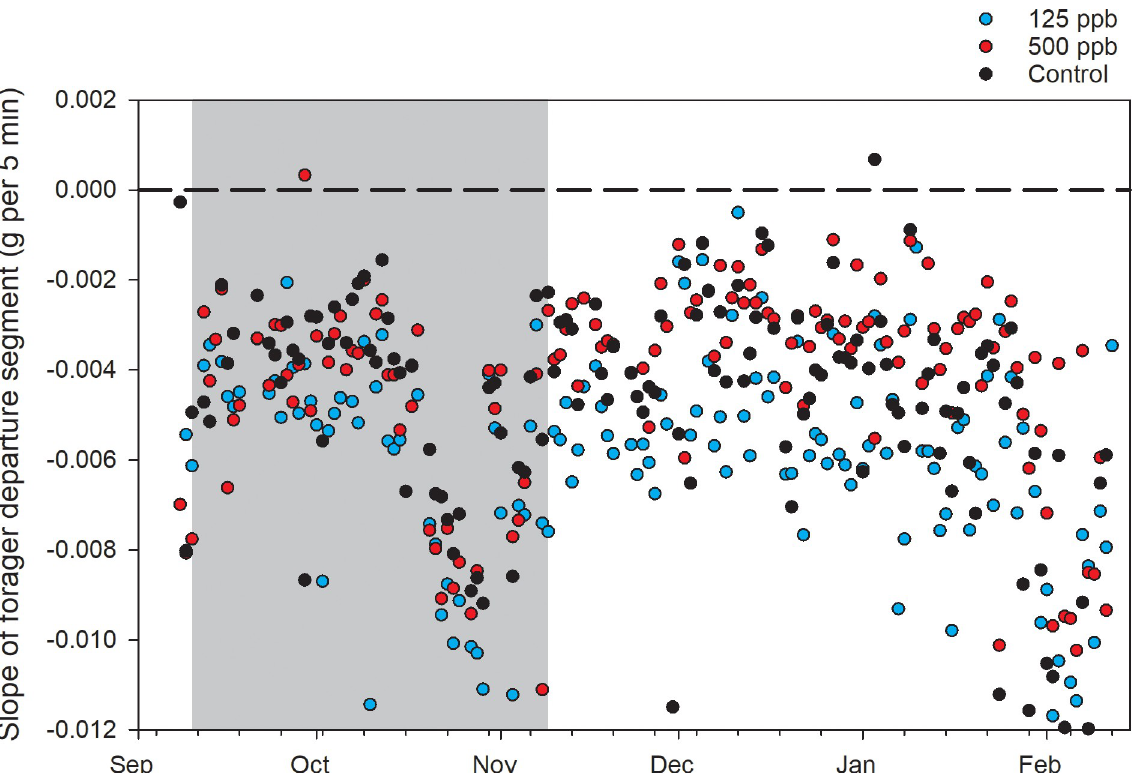
Fig 3. Segment slopes associated with departing foragers for the Fall 2017 experiment. Gray area shows the treatment period. Dashed black horizontal line shows slope = 0.